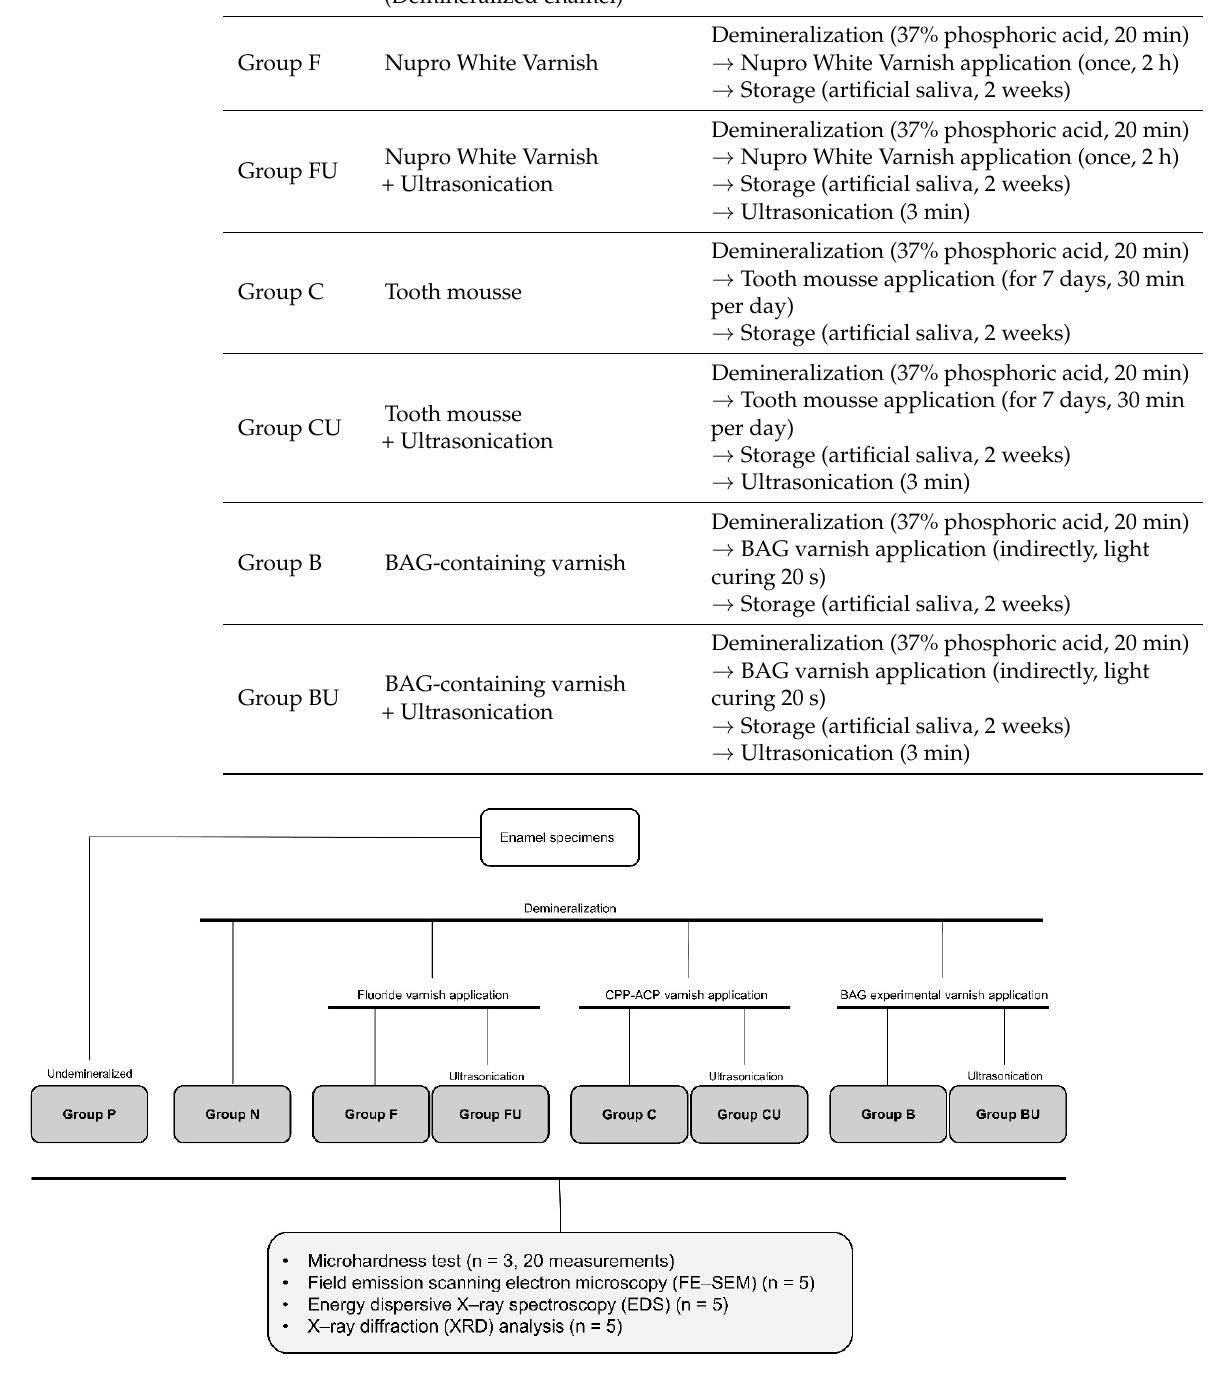
Figure 1. Classification of experimental groups and analysis methods.